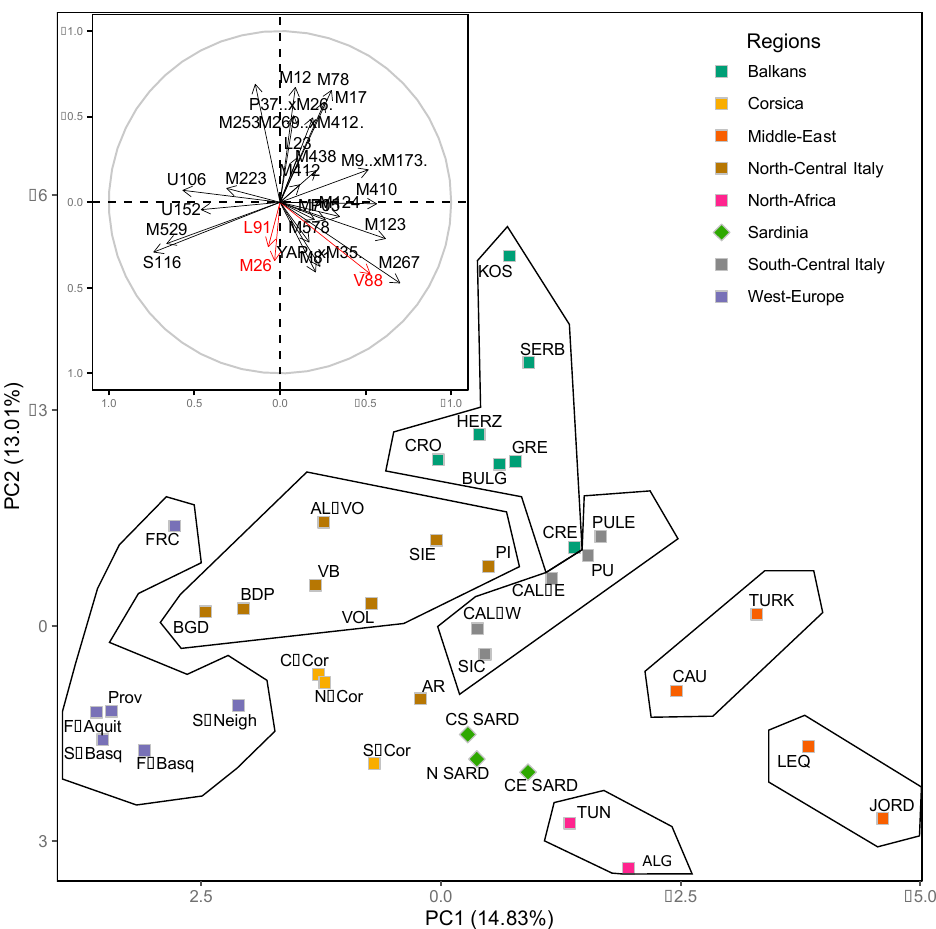
Figure 3. Principal component analysis performed using haplogroup frequencies in the Sardinian samples of the present study compared with those of relevant populations from the literature at the highest possible level of resolution (Table S2). Of the total variance, 27.84% is represented: 14.83% by the first PC and 13.01% by the second PC. The inset illustrates the contribution of each haplogroup. S-Neigh: Spanish from Western Bizkaia, Cantabria, Burgos, La Rioja, North Aragon; S-Basq: Spanish